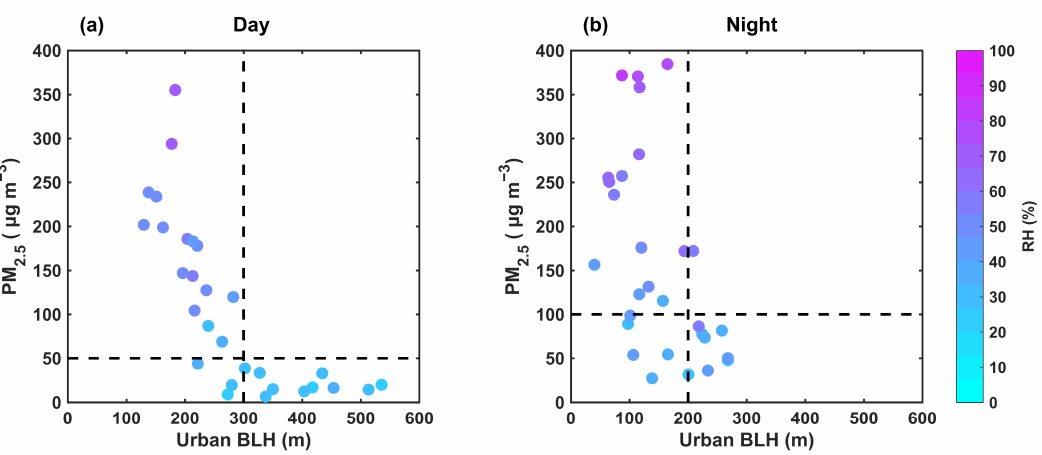
Figure 6. Relationships between PM 2.5 concentration and urban BLH derived from threshold method combined with the Richardson number method over Beijing during daytime ( a ) and nighttime ( b ), with the dots indicating the accompanying